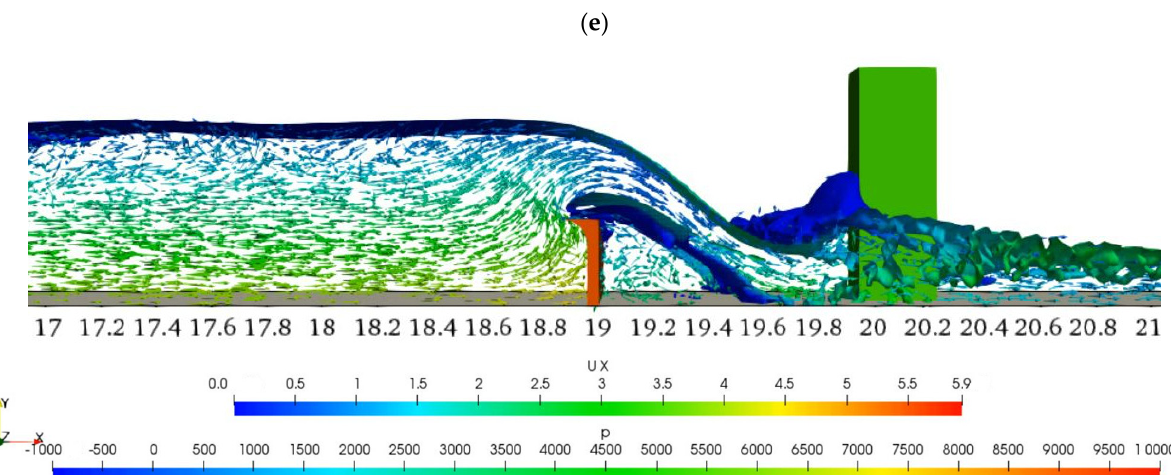
Figure 10. Flow interaction with the inland structure at different time instances in the presence of an LRC for d o = 0.9 m, L = 1 m and Wall 4. (Ux-Surge velocity in the x -direction in m/s; P- pressure in N/m 2 ). Vectors are colored with pressure, and the free surface is colored with Ux. The numbers in the images represent the distance in the x-direction from the tank origin in meters: ( a ) t ( g/d o ) 0.5 = 7.92; ( b ) t ( g/d o ) 0.5 = 14.19; ( c ) t ( g/d o ) 0.5 = 15.35 ( t C ); ( d ) t ( g/d o ) 0.5 = 17.49 ( t D ); ( e ) t ( g/d o ) 0.5 = 25.58 ( t E ).